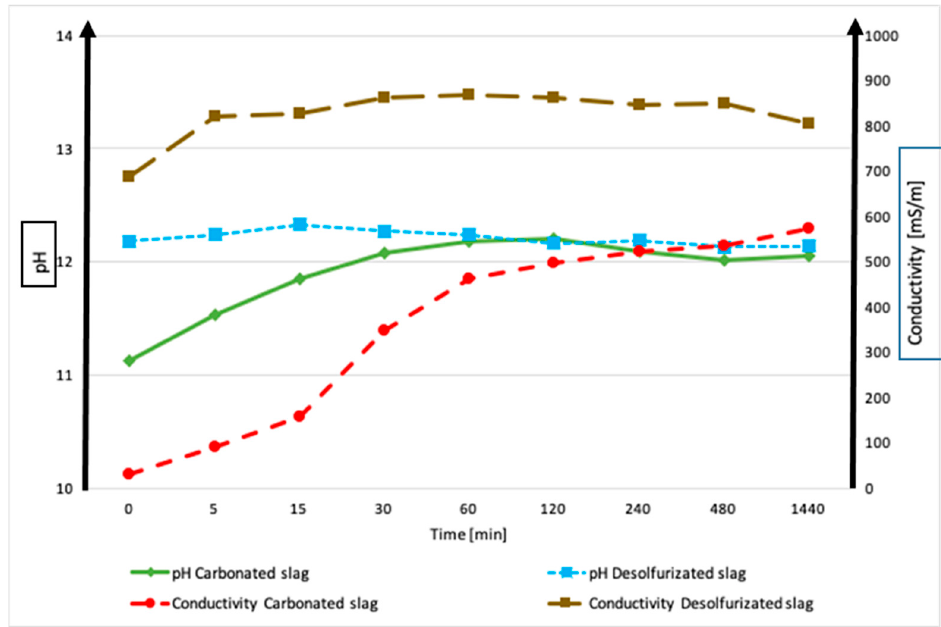
Figure 5. pH and conductivity of carbonated and desulfurization slags. The error associated with these measurements is approx. 2% for pH and 8% for conductivity caused by sample variability.